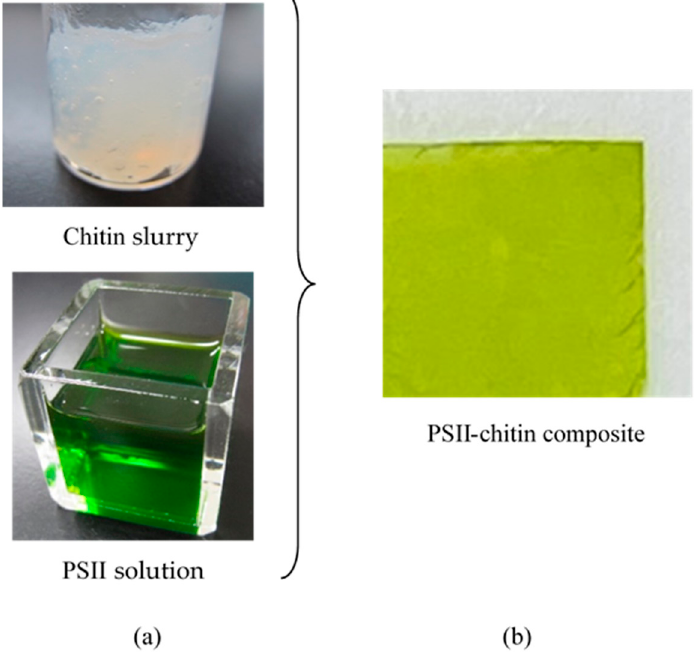
Figure 2. Chitin slurry and PSII solution ( a ), and photograph of the PSII–chitin composite ( b ).